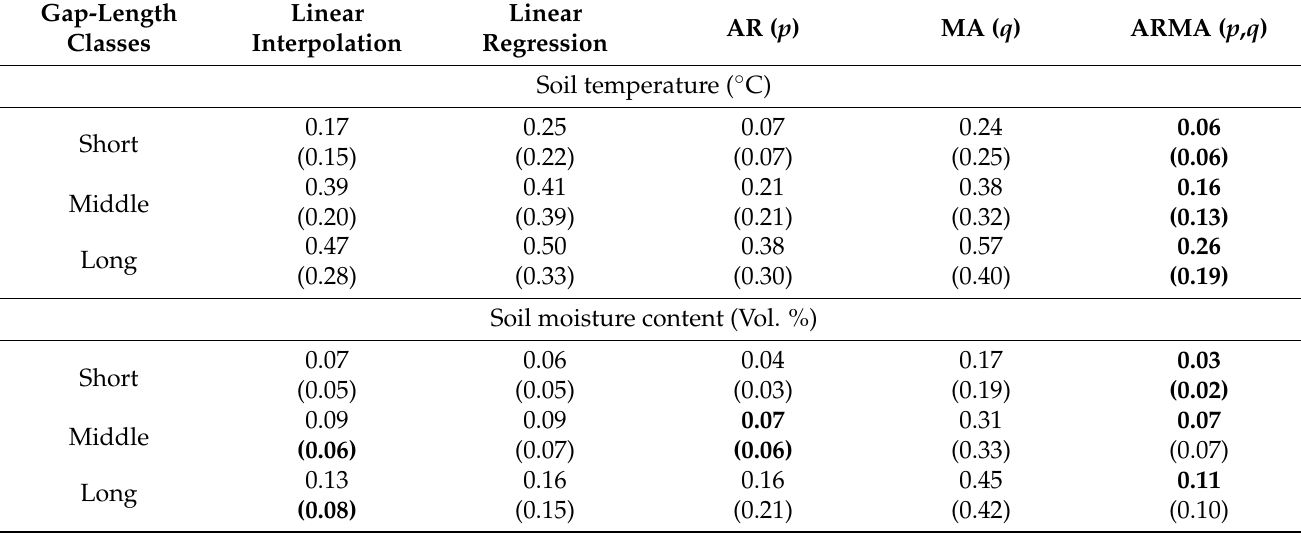
Table 3. The mean absolute error (MAE) of the soil properties estimations via different methods depending on the length of data gaps; measurements at the 30 cm depth of the arable land (Monolith 1); natural steppe vegetation (Monolith 2); mean (standard deviation).